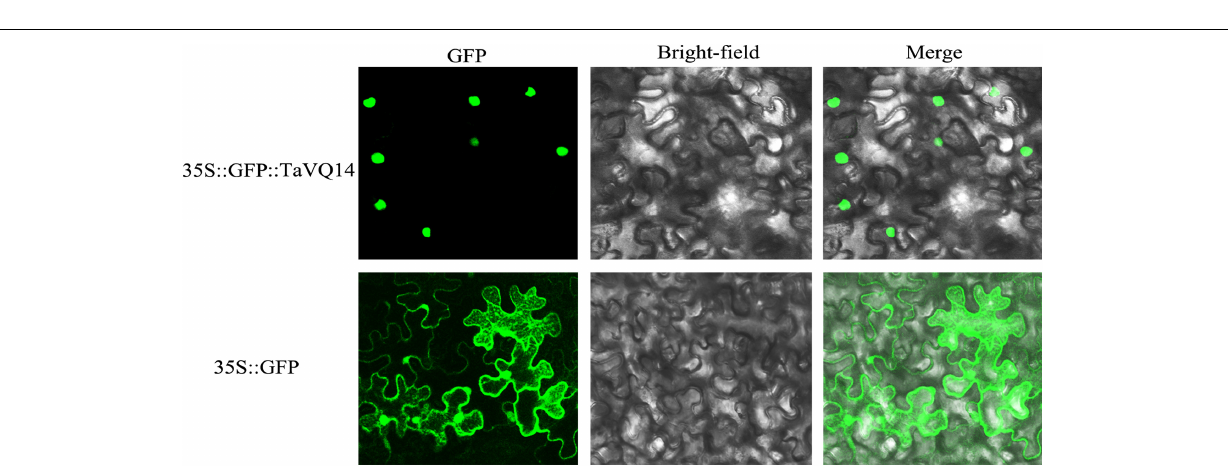
FIGURE 3 | Nuclear localization of TaVQ14. The construct 35S:GFP:TaVQ14 and the control vector 1305 (35S:GFP) were transformed into Nicotiana tabacum leaves. The GFP signals in root cells were observed by confocal microscopy.